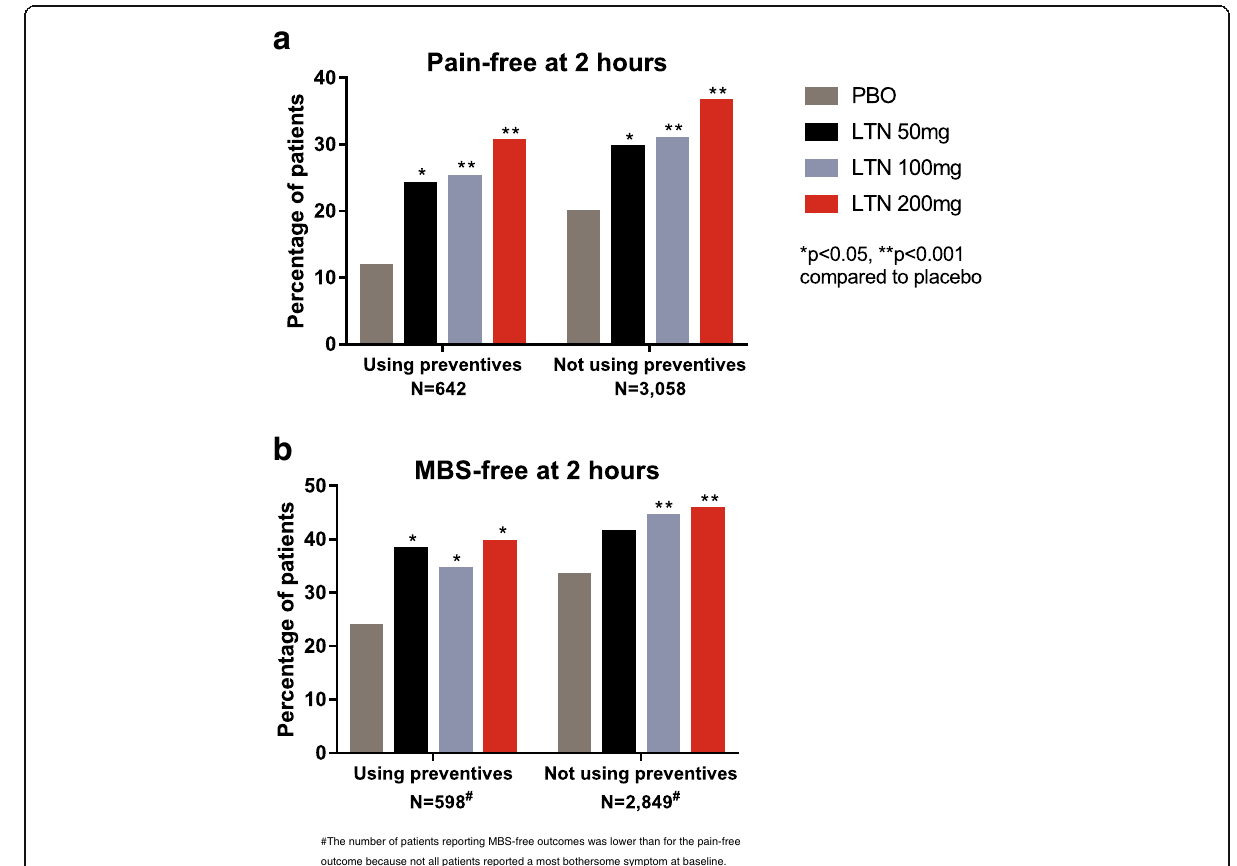
Fig. 1 Pain-free and most bothersome symptom-free (MBS-free) at 2 h following lasmiditan treatment were similar in patients using and not using migraine preventive medications. Patients using and not using migraine preventive medications treated a migraine headache with lasmiditan (LTN) 50 mg, 100 mg, or 200 mg or placebo (PBO). At 2 h postdose, patients rated their pain and presence or absence of nausea, phonophobia, or photophobia. Colored bars show the percentages of patients reporting a complete absence of pain ( 1a ) or MBS ( 1b ) at 2 h. Comparisons of lasmiditan effect in the group of patients using versus not using preventive medications were not significant for any treatment group for either pain-free or MBS-free (all interaction p -values >